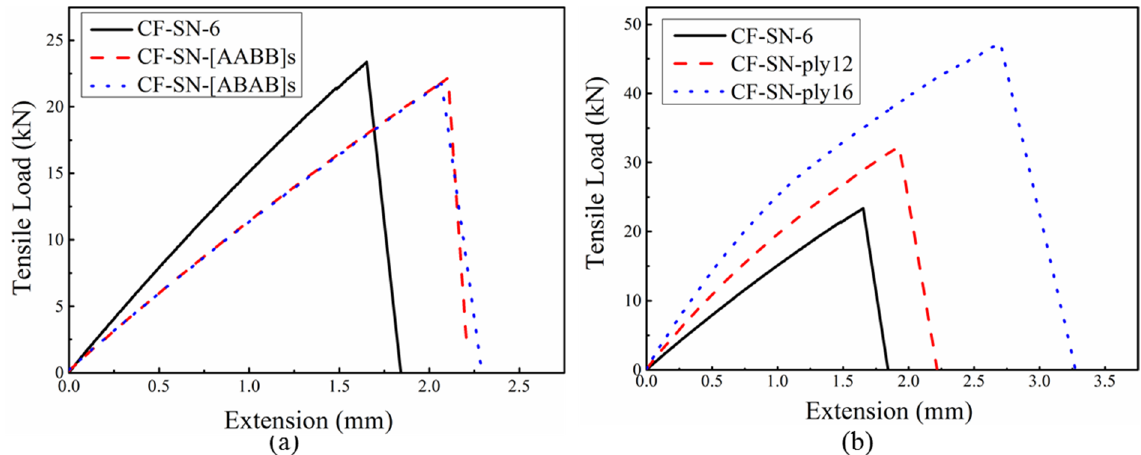
Figure 6. Tensile load–displacement curves of straight ‐ notched specimens under tensile load. ( a ) Different lay ‐ up sequence group; the ply angle exhibits a significant effect on the tensile strength, whereas the lay ‐ up sequence does not. ( b ) Different laminated thickness group; the greater the thickness, the higher the stiffness and peak tensile load.